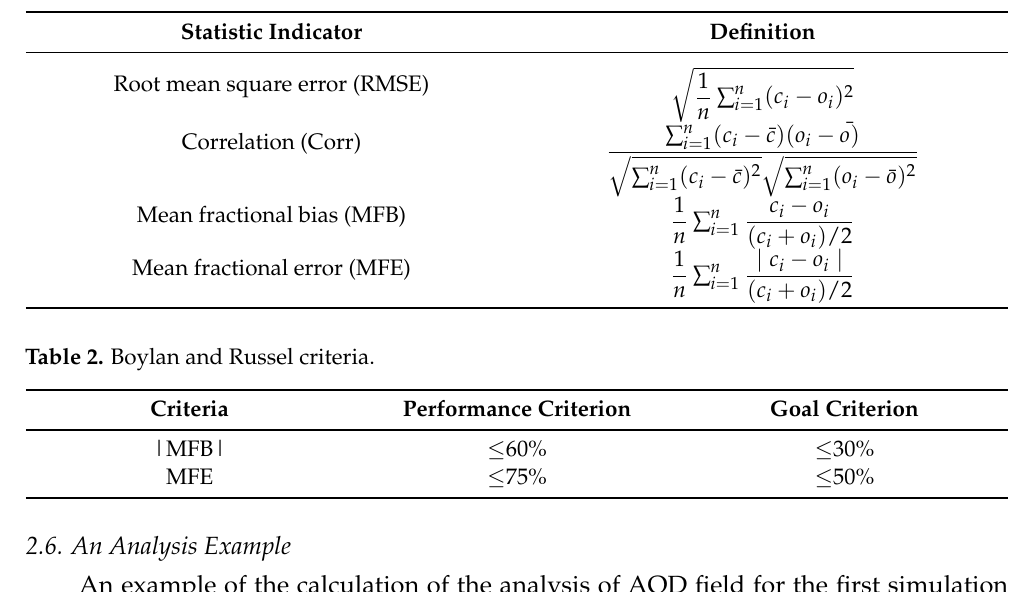
Table 1. Definitions of the statistics used in this work. ( o i ) i and ( c i ) i are the observed and the simulated concentrations at time and location i, respectively. n is the number of data.